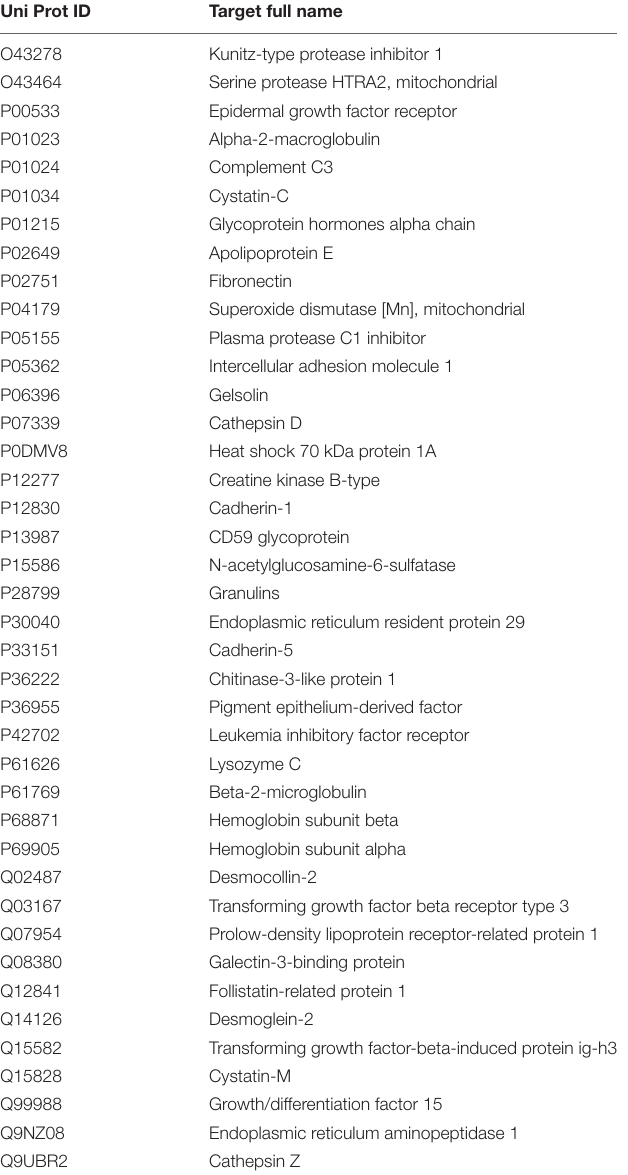
TABLE 2 | Proteins secreted by PHT cells in vitro and by the human placenta into the fetal circulation in vivo . Uni Prot ID